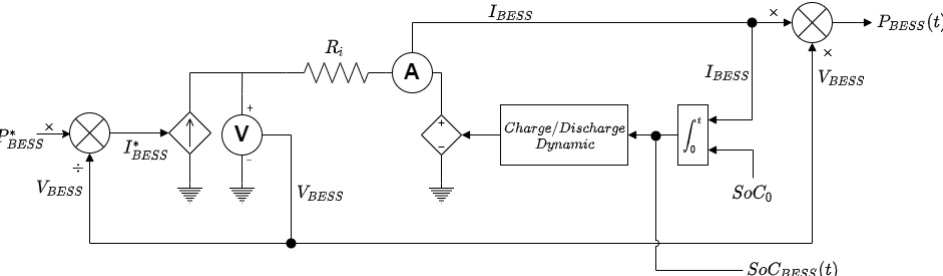
Figure 1. Equivalent model of a BESS. Where P ∗ its related current incoming to the BESS. On the other hand, R i is the internal resistant of BESS, SoC 0 and SoC BESS refers to previous and current BESS state-of-charge, respectively. Finally, V BESS and I BESS indicate the voltage and current measured on the